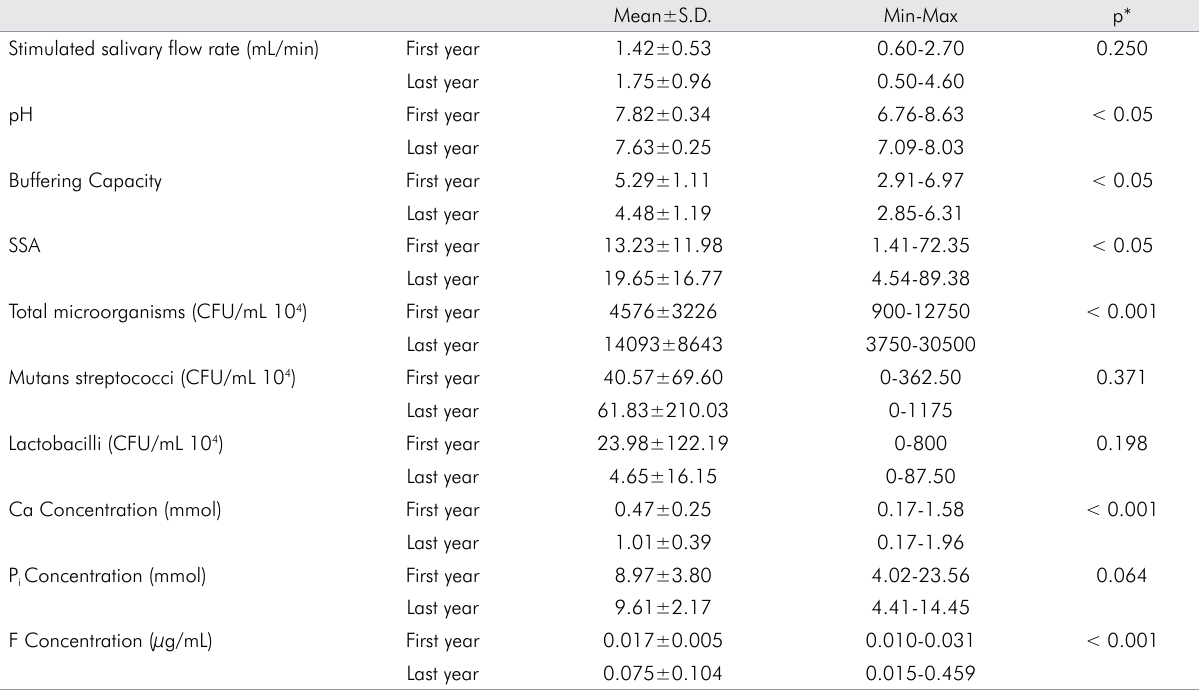
Table 1. Salivary factors of students of the first year (n = 44) and last year (n = 32), FOP/UNICAMP 2011.